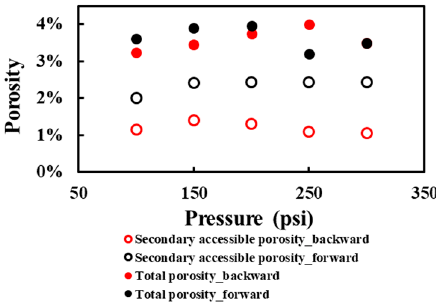
Figure 4. Total porosity and secondarily accessible porosity in the core in the forward and backward directions. Note the pressures are approximated beginning at 100 psi and with a step of 50 psi.